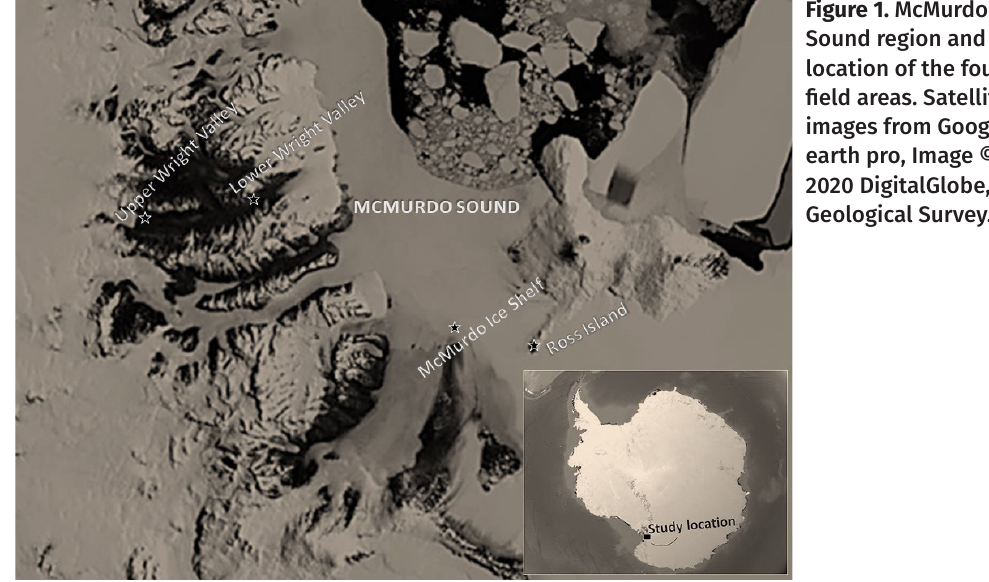
Figure 1. McMurdo Sound region and the location of the four field areas. Satellite images from Google earth pro, Image